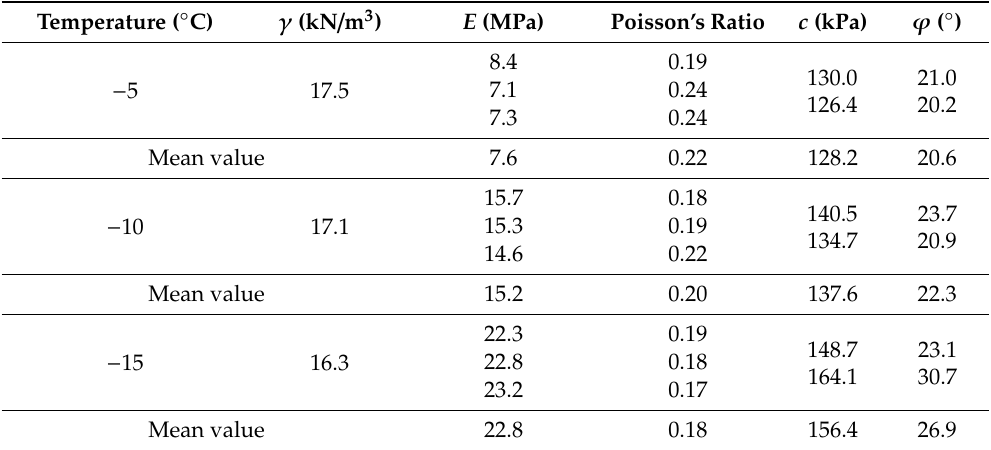
Table 6. Physical and mechanical parameters of frozen soil at three temperatures.